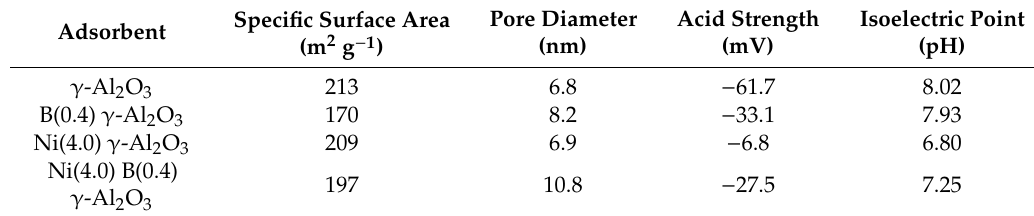
Table 1. Characterization results for γ -Al 2 O 3 modified with boron and